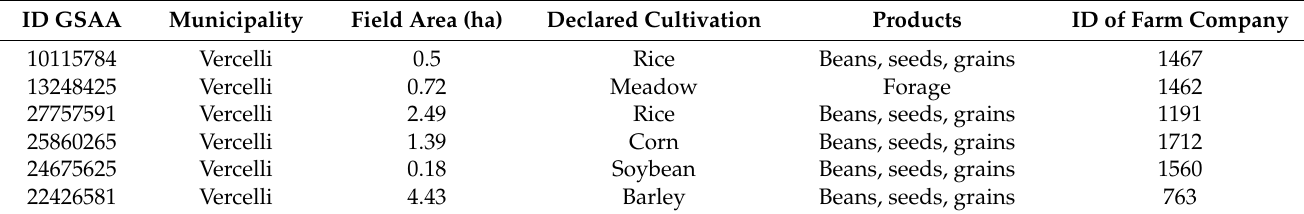
Table 4. Example data contained in Geo Spatial Aid Application